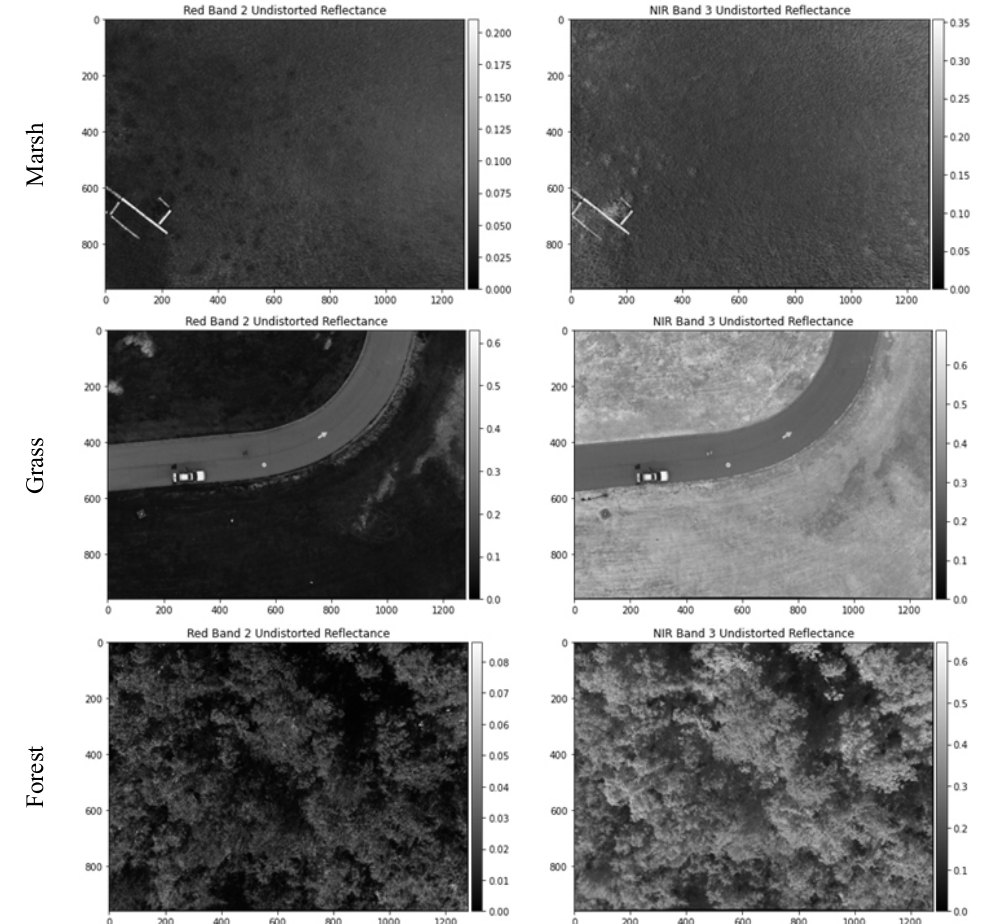
Figure 7. Example RedEdge-M surface reflectance images (marsh, grass, and forest) after at-sensor radiometric correction. Only red and NIR bands are displayed. Table 6. The min-max ranges of the corrected reflectance images for marsh, grass, and forest. The extreme values are highlighted in